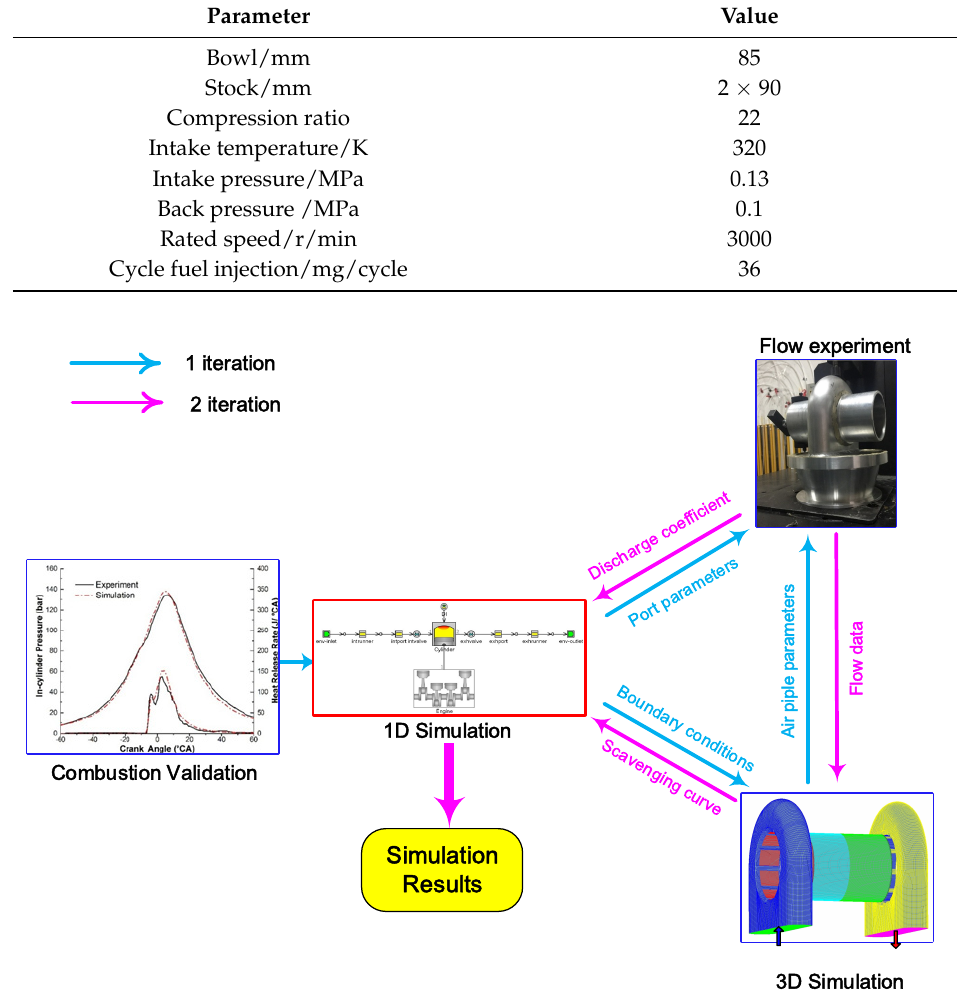
Table 1. Parameters of the OP2S diesel engine.